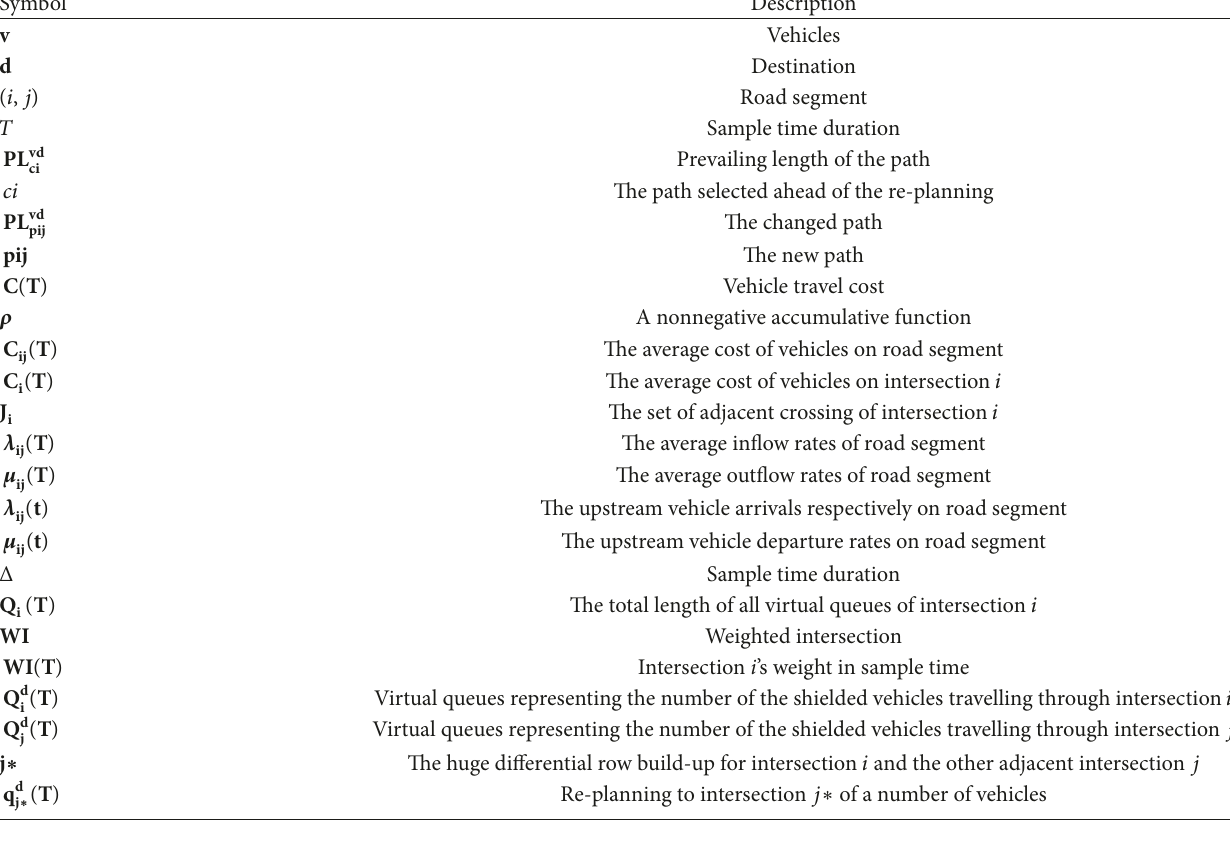
Table 1: Summary of the important mathematical notations.